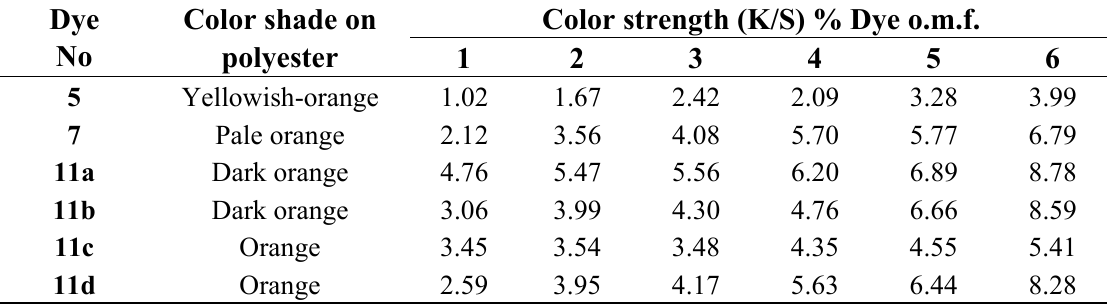
Table 2. Color strengths of azo disperse dyes on polyester fabrics of reused dyebaths. Dye Color shade on No